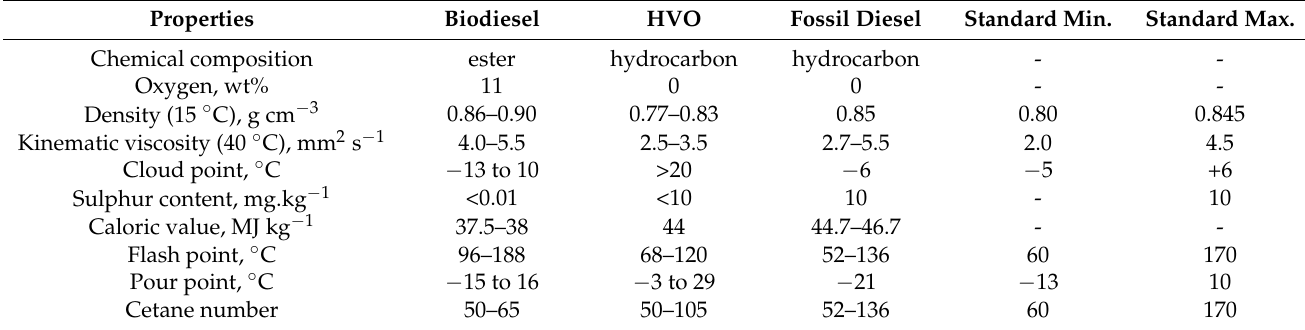
Table 2. Properties of biodiesel, HVO, and fossil diesel (including minimal and maximal standard values for diesel) [1]. Properties Biodiesel Fossil Diesel Standard